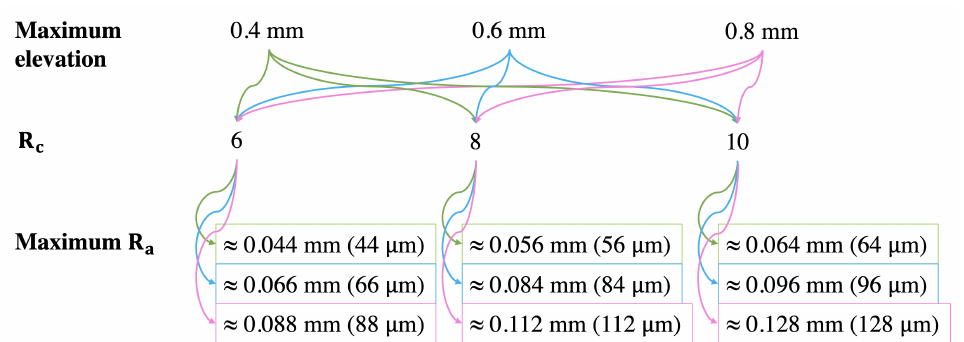
Figure 3. Values of maximum elevation and roughness constants (denoted as R c ) and calculated maximum roughness amount (denoted as R a ). The maximum R a is an approximation of what we would have physically in the prints. Three elevation levels at three roughness constants ( R c ) gave nine